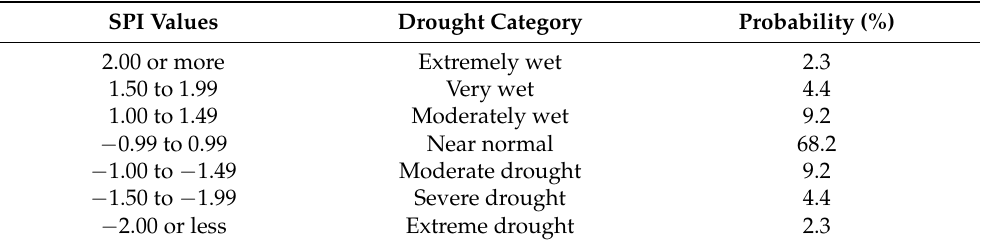
Table 4. Drought classification based on SPI value and corresponding event probabilities based on the approximation that SPI values follow a standard normal